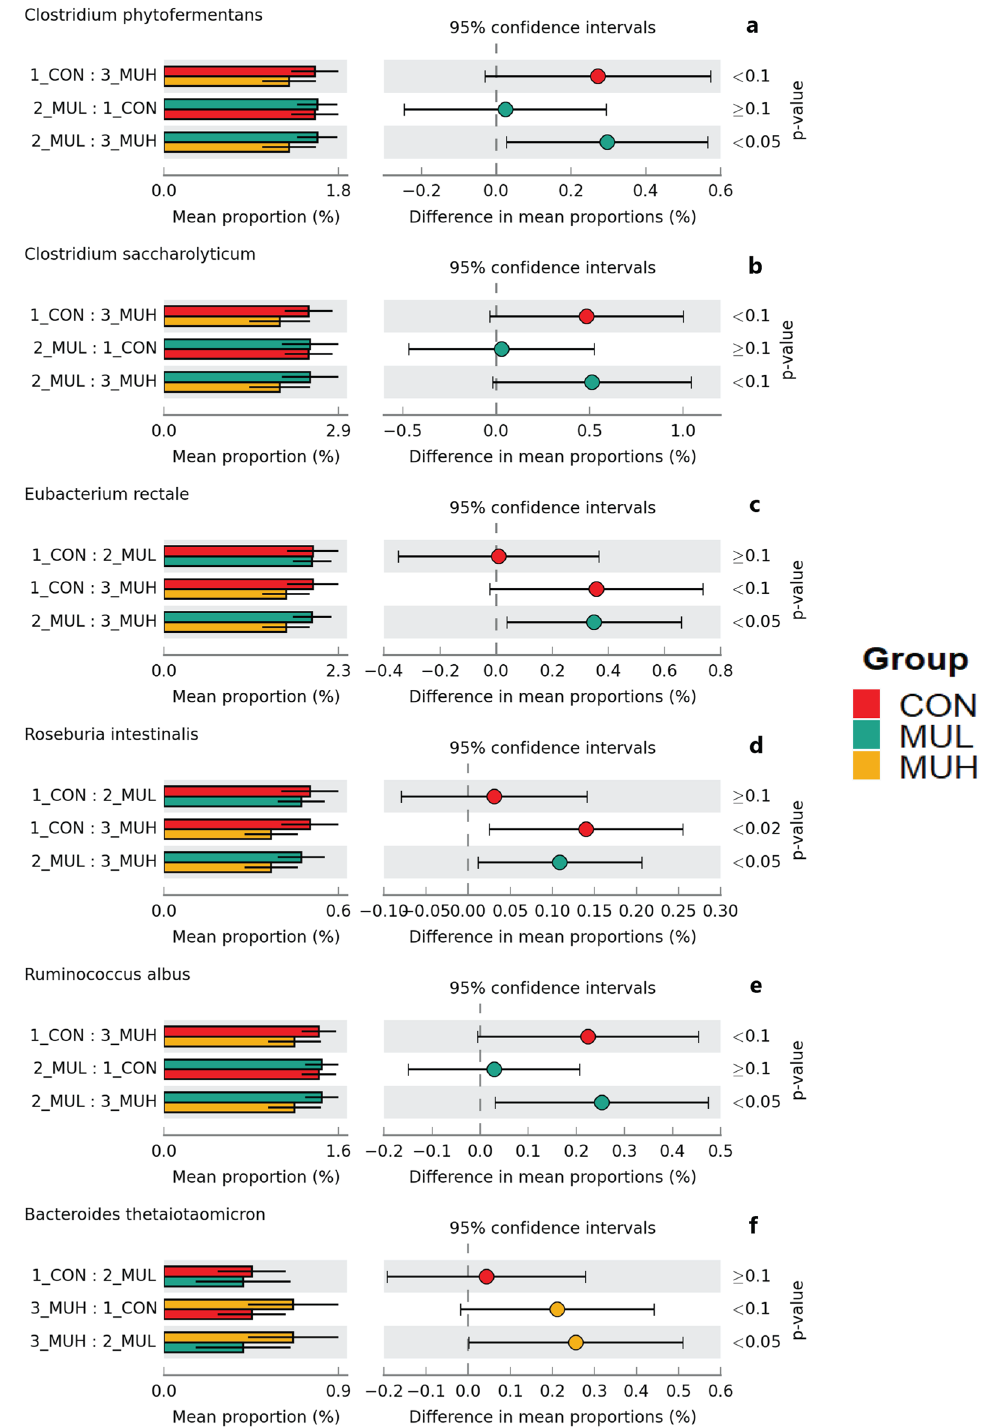
Figure 8. Extended error bar plots of mean relative abundance differences of caecal C. phytofermentans ( a ), C. saccharolyticum ( b ), E. rectale ( c ), R. intestinalis ( d ), R. albus ( e ), and B. thetaiotaomicron ( f ) between CON, MUL, and MUH at slaughter (42 d). Colored bars and black lines indicate the mean relative abundance and standard deviation of the bacterial species, respectively (left side). Colored dots inside the 95% confidence intervals signify the difference of mean relative abundance of the bacterial species for each pairwise comparison (center). Games-Howell post-hoc test p -values are reported (right